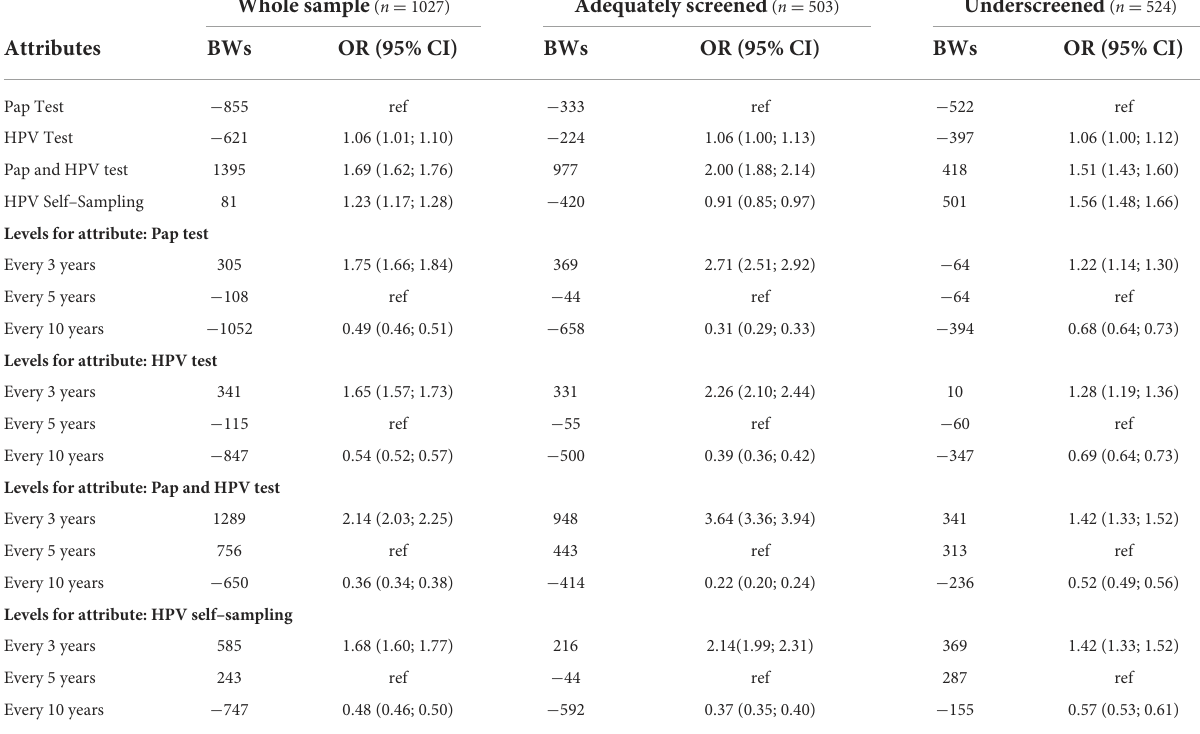
TABLE 2 Preferences for screening intervals (Domain